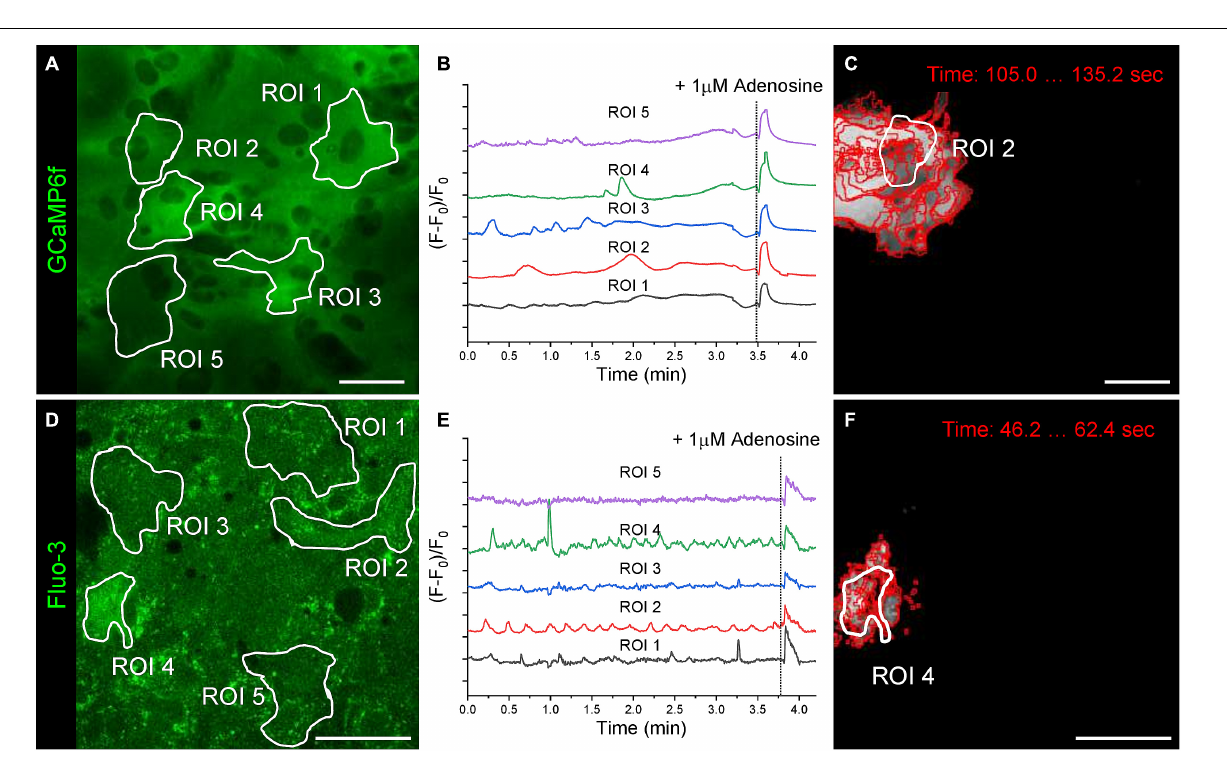
FIGURE 4 | Spontaneous and induced Ca ++ events in primary astrocytes. (A) Astrocytes expressing the genetically encoded calcium sensor GCaMP6f after 21 days of cultivation. White outlines indicate regions of interest (ROIs) that were selected for fluorescence intensity over time analysis based on putative cell borders detected by phase contrast microscopy. (B) Fluorescence over time traces (F–F 0 )/F 0 are shown for the five ROIs selected in (A) . (C) Ca ++ event boundaries detected by the Astral software at consecutive time points (grain size 4 pixel, threshold SD*5) is overlaid with the corresponding ROI outline. (D) Astrocytes loaded with the calcium sensor Fluo-3 after 21 days of cultivation. ROIs are outlined in white. (E) Fluorescence over time traces (F–F 0 )/F 0 are shown for the five ROIs selected in (D) . (F) Ca ++ event boundaries detected by the Astral software at consecutive time points (grain size 4 pixel, threshold SD*2) is overlaid with the corresponding ROI outline. Scale bars, 50 µ